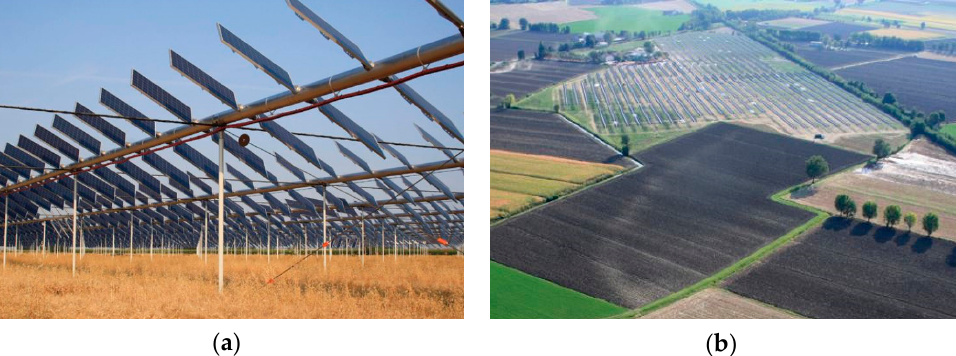
Figure 17. ( a ) View of the PV track system during the first crop (photo: © REM) ; ( b ) aerial view of the solar plant in landscape (photo: © REM).